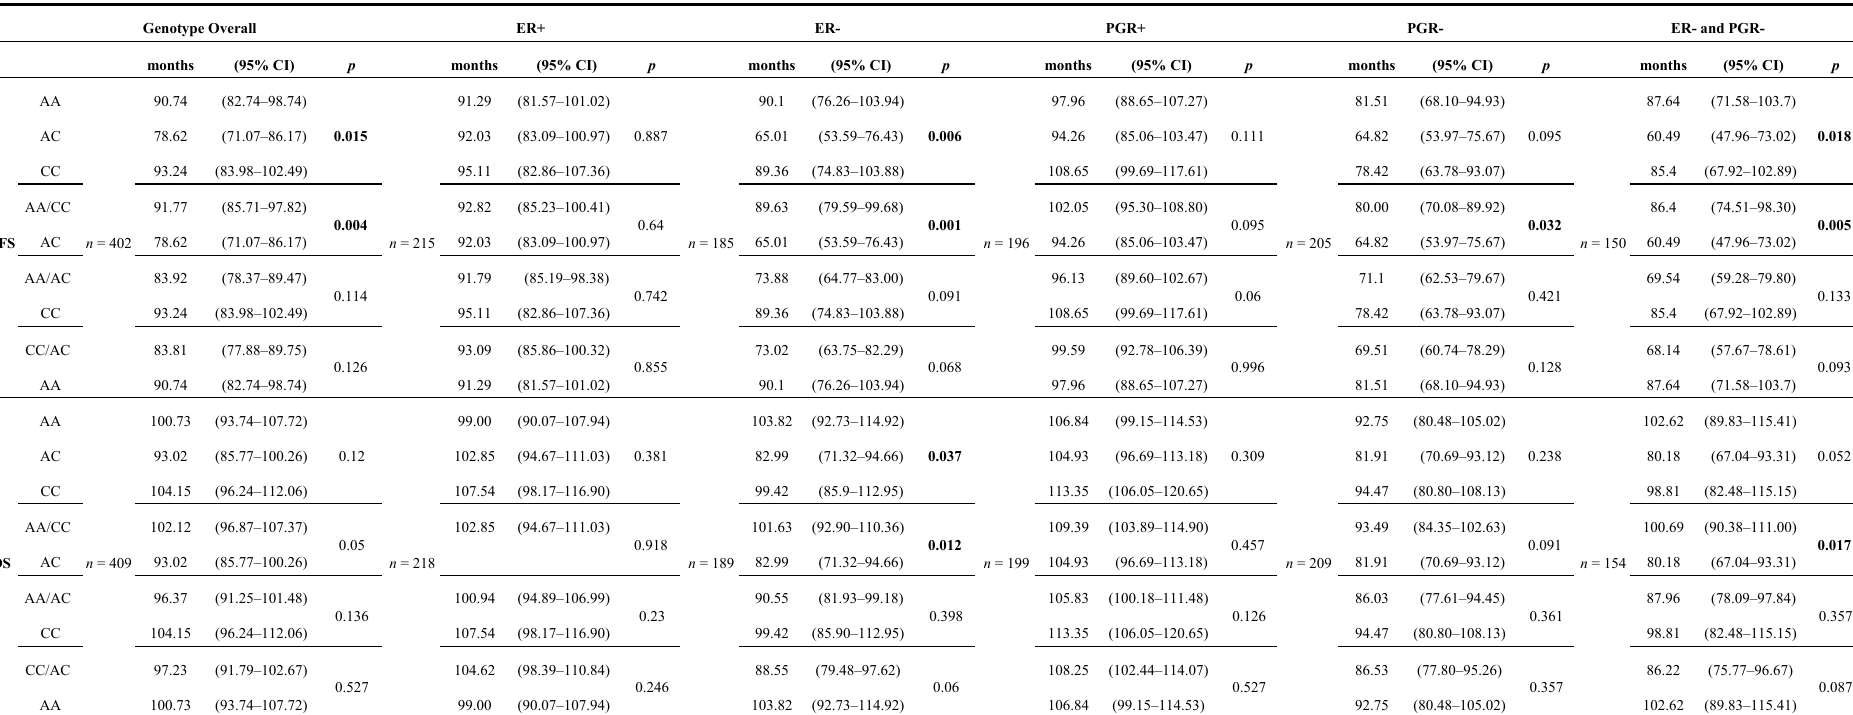
Table 2. Analysis of disease-free survival (DFS) and overall survival in the global breast cancer population and in the subgroups of hormonal receptors by rs3736729 ( GCLC )